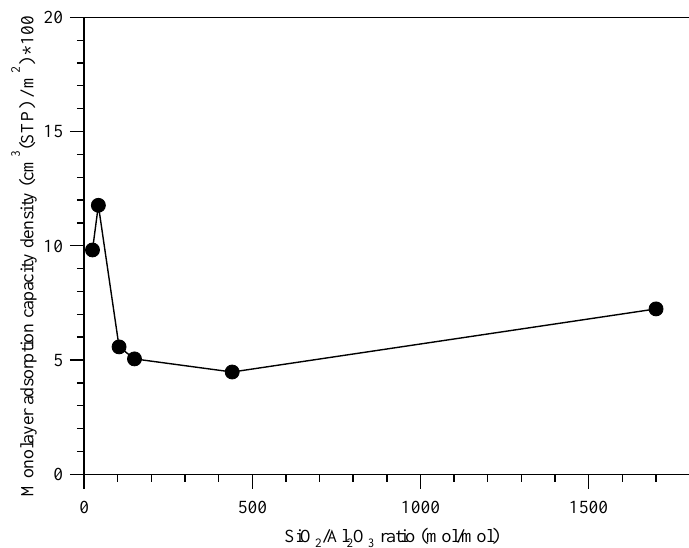
Figure 7. Monolayer adsorption capacity density as a function of SiO 2 /Al 2 O 3 ratio with zeolite beta. STP: standard ambient temperature and pressure.